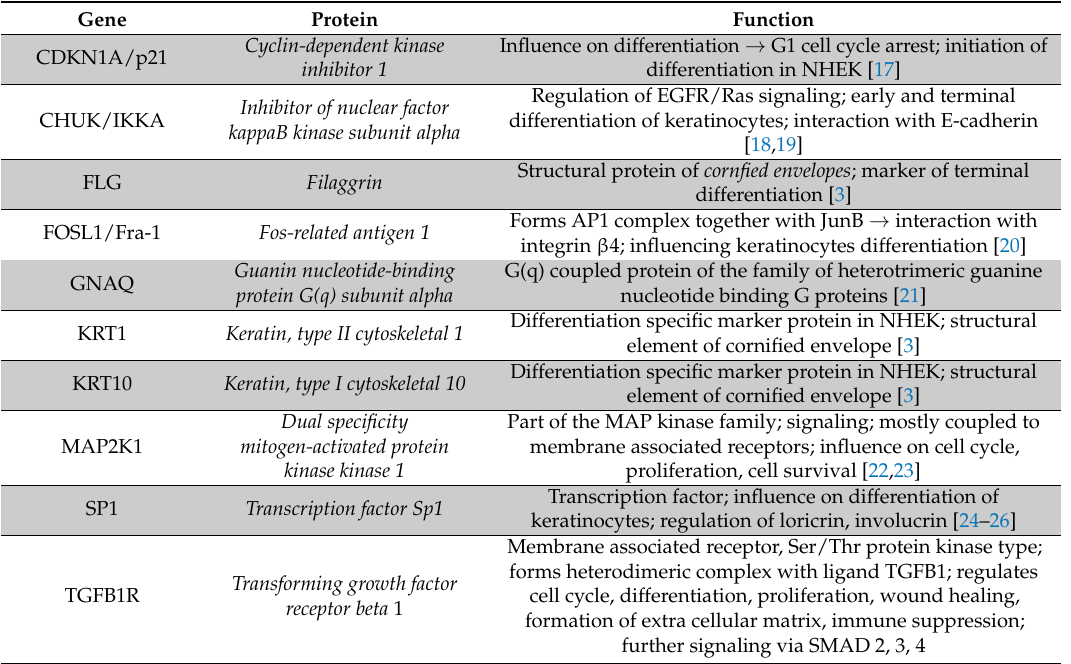
Differentiation specific marker protein in NHEK; structural element of cornified envelope